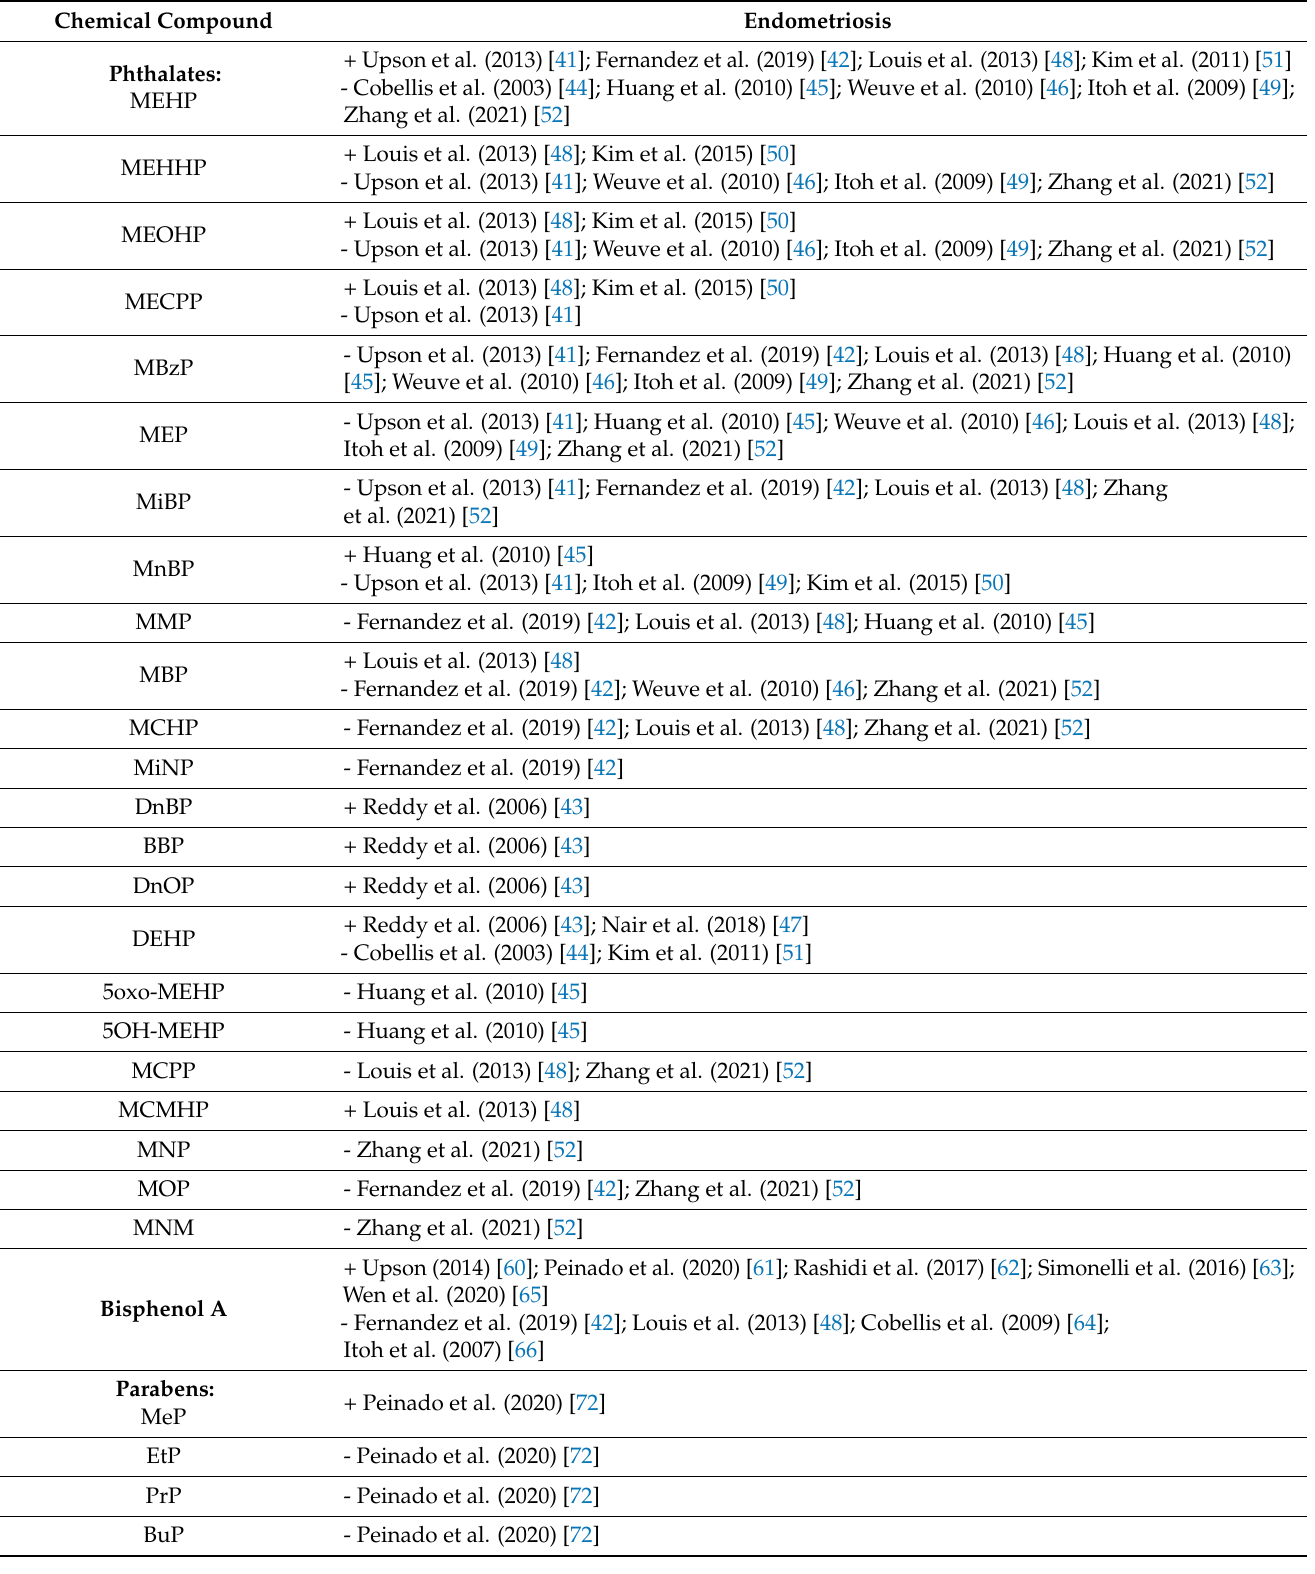
Table 6. Exposure to non-persistent endocrine disrupting chemicals exposure and